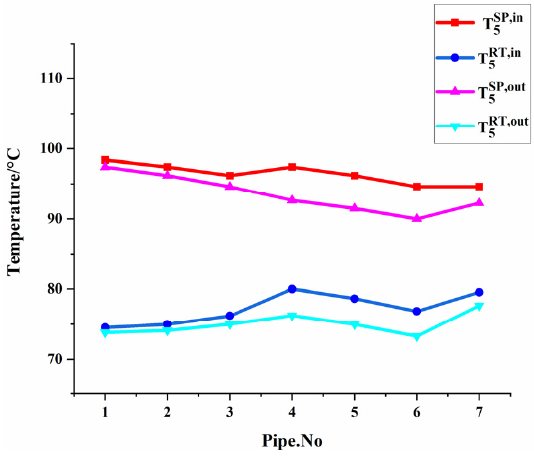
Figure 13. The temperatures of the supply and return system at off-peak times.